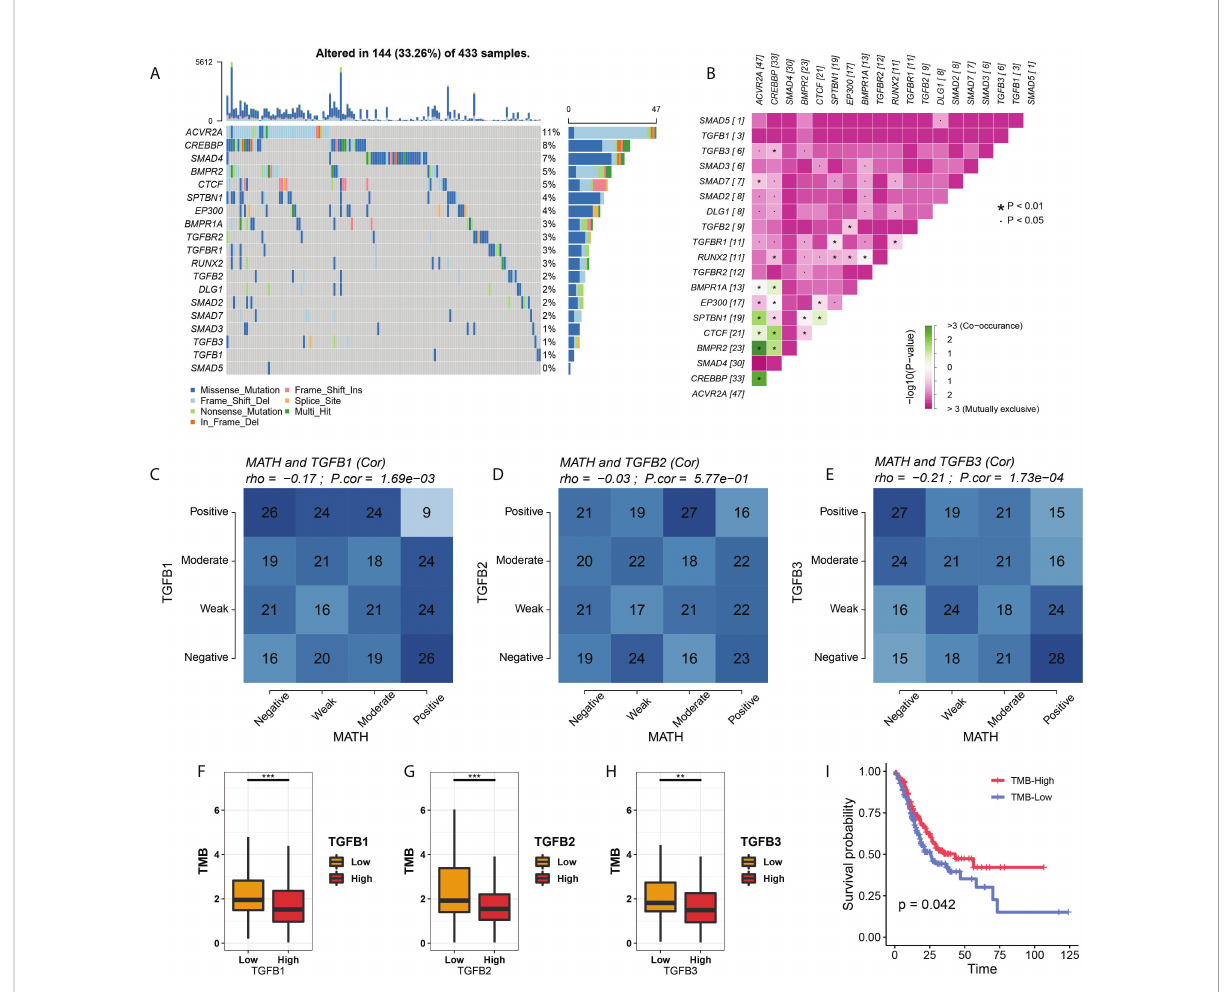
FIGURE 9 TGF b with MATH and TMB. (A) Waterfall plot of TGF b – related gene mutations. (B) Exclusive and Co – occurrence analysis of pairwise mutant genes. (C – E) Correlation analysis of TGF b and MATH. (F – H) Comparison of TMB among different TGF b groups. (I) Kaplan – Meier survival analysis of TMB in STAD. * P < 0.05; ** P < 0.01; *** P <